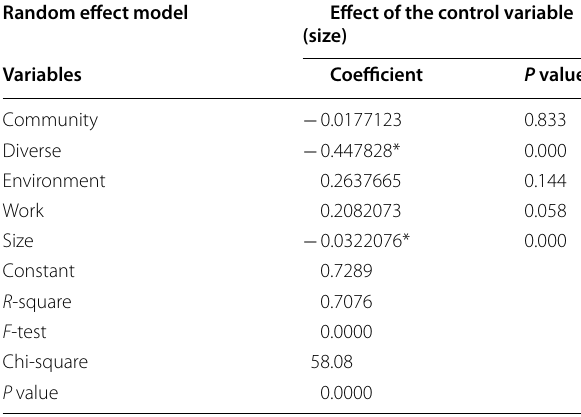
The result is evaluated based on a 95% level of significance Table 5 Panel data analysis with ROE as the dependent variable